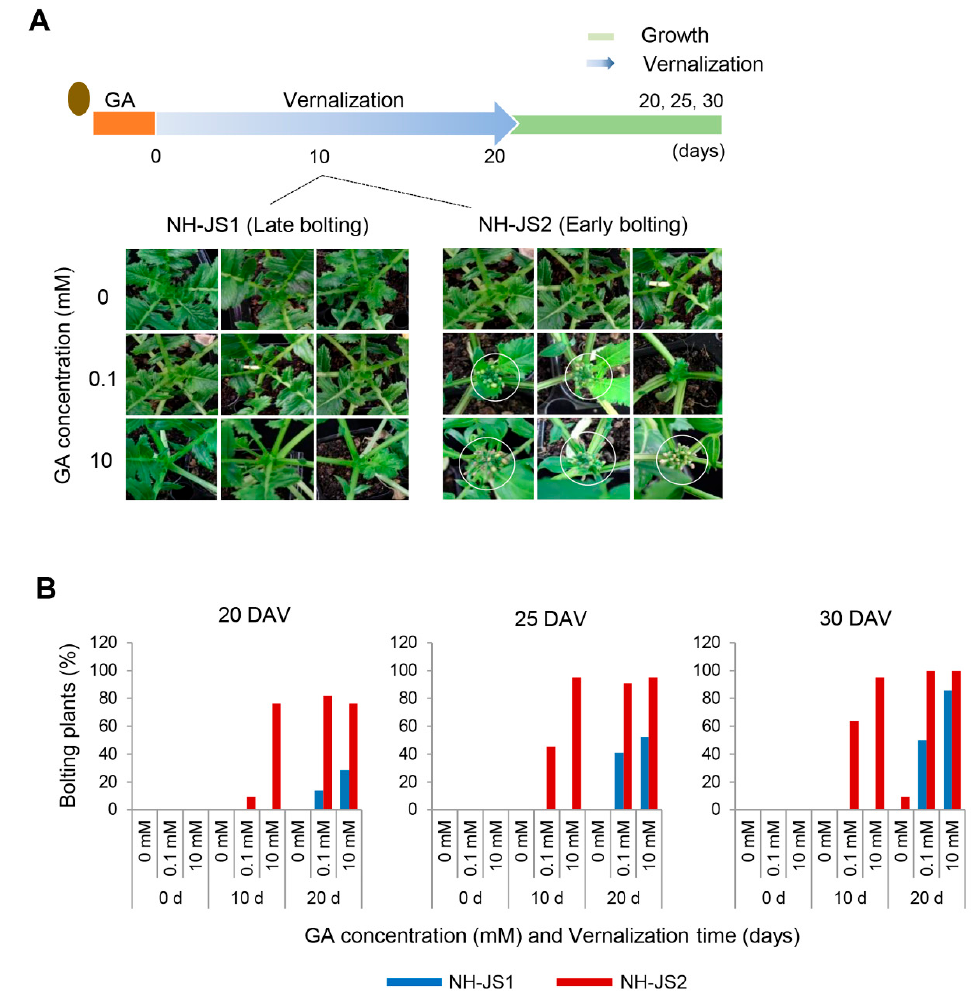
Figure 1. Phenotypes of NH-JS1 and NH-JS2 inbred radish lines under vernalization after gibberellin treatment. ( A ) Bolting phenotypes of NH-JS1 and NH-JS2 under vernalization for 10 days following